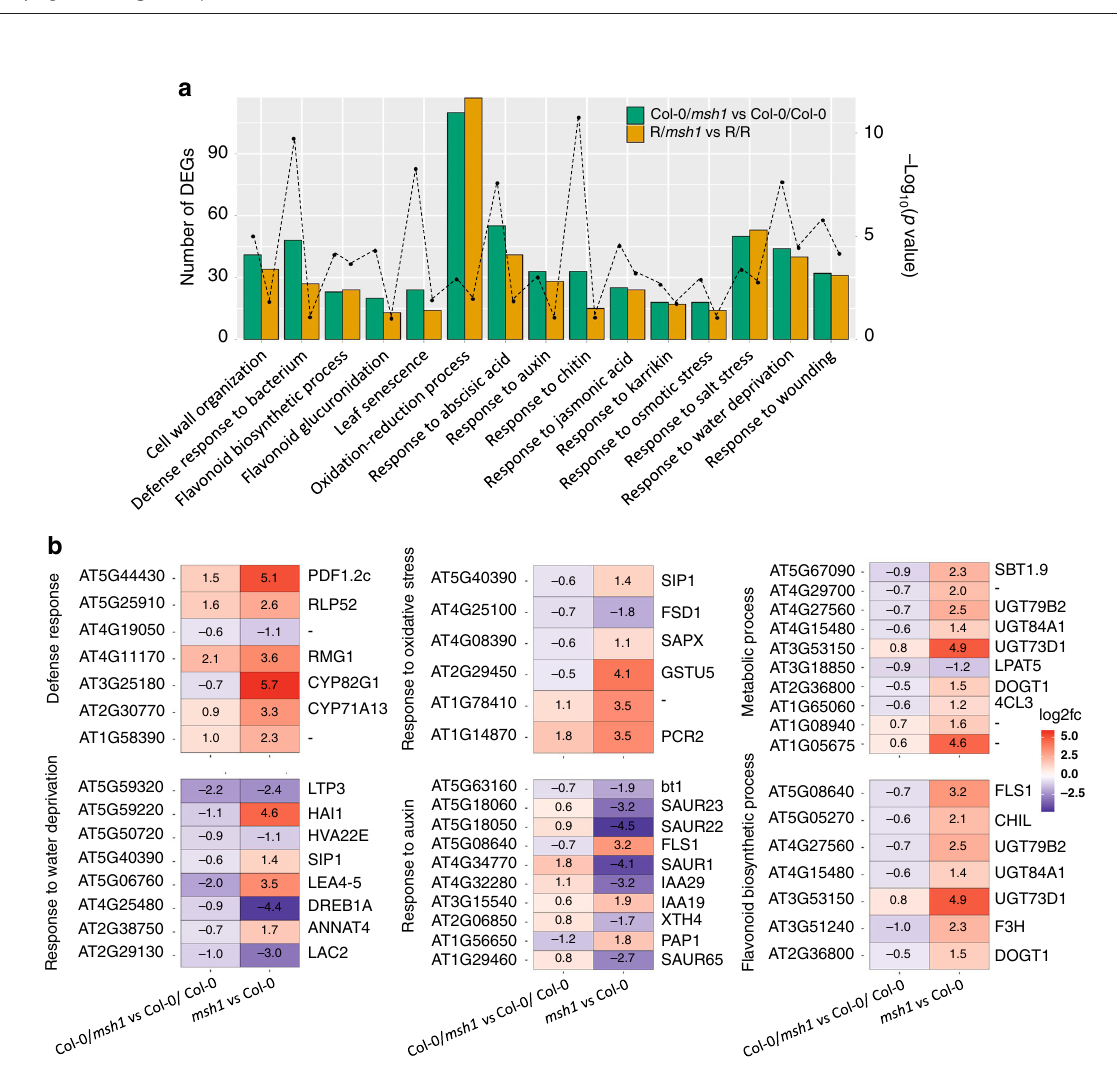
Fig. 2 Differentially expressed genes (DEGs) and enriched pathways in graft progenies. a Signi fi cant enriched GO pathways shared by Arabidopsis graft progeny (Col-0/ msh1 vs. Col-0/Col-0) DEGs and tomato graft progeny (R/ msh1 vs. R/R) DEGs. Bar graph represents number of DEGs and dotted line represents − log 10 ( p -value) for the enrichment test. One-sided Fisher ’ s exact test was used to compute FDR as implemented in DAVID GO. b DEGs from the signi fi cant enriched GO pathways of Arabidopsis graft progenies (Col-0/ msh1 vs. Col-0/Col-0) and msh1 mutant ( msh1 vs. Col-0). GO biological process enrichment categories above the cutoff, FDR < 0.01, are shown. DAVID GO was used to conduct the analysis. Source data underlying a are provided as a Source Data fi